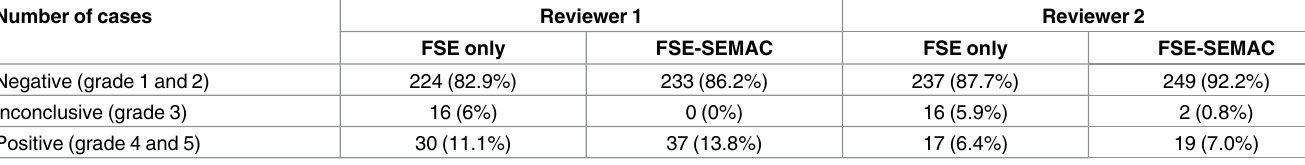
Table 3. Summary for diagnosis of post-operative complications.